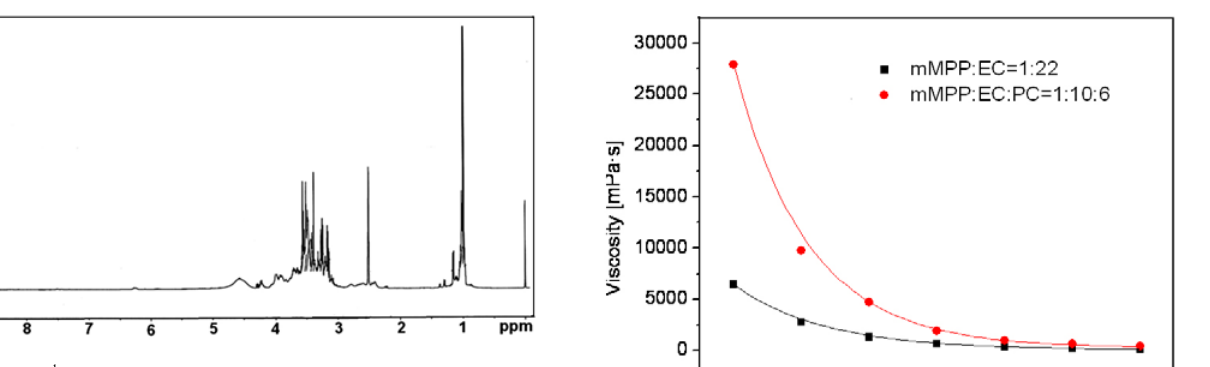
Fig. 4 . 1 H-NMR spectrum of oligoetherol from mMPP:EC:PC =1:10:6